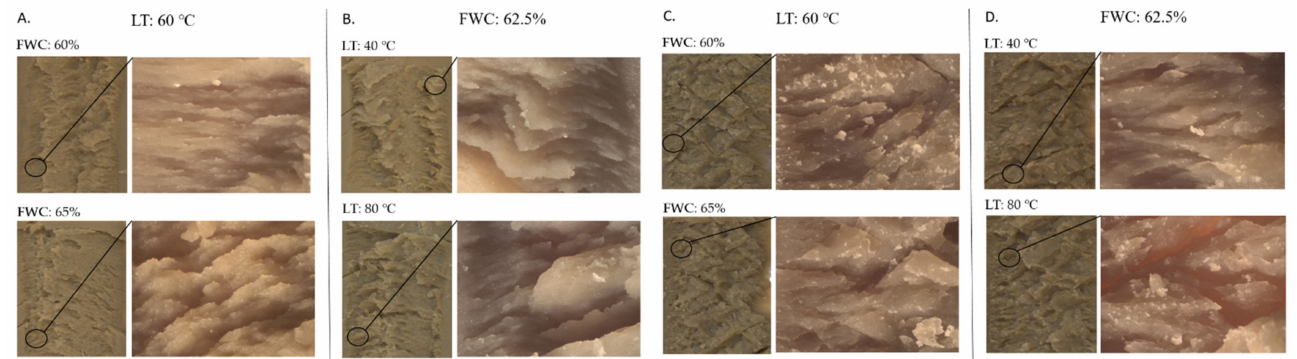
Figure 5. Pictures of samples taken with a digital camera and stereomicroscopy. Sample containing 30% faba bean protein isolate extruded at an LT of 60 ◦ C ( A ), sample containing 30% faba bean protein isolate extruded at an FWC of 62.5% ( B ), samples containing 70% faba bean protein isolate extruded at an LT of 60 ◦ C ( C ), and samples containing 70% faba bean protein isolate extruded at an FWC of 62.5% ( D ). LT = long cooling die temperature; FWC = feed water